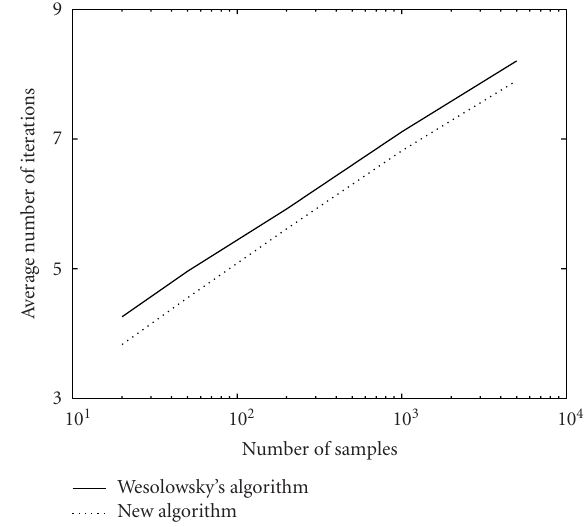
Figure 5: Comparison on the average number of iterations of Wesolowsky’s and LA algorithms. The dimensions of the sample sets are chosen as [20, 50, 200, 1000, 5000], each having 1000 averaging